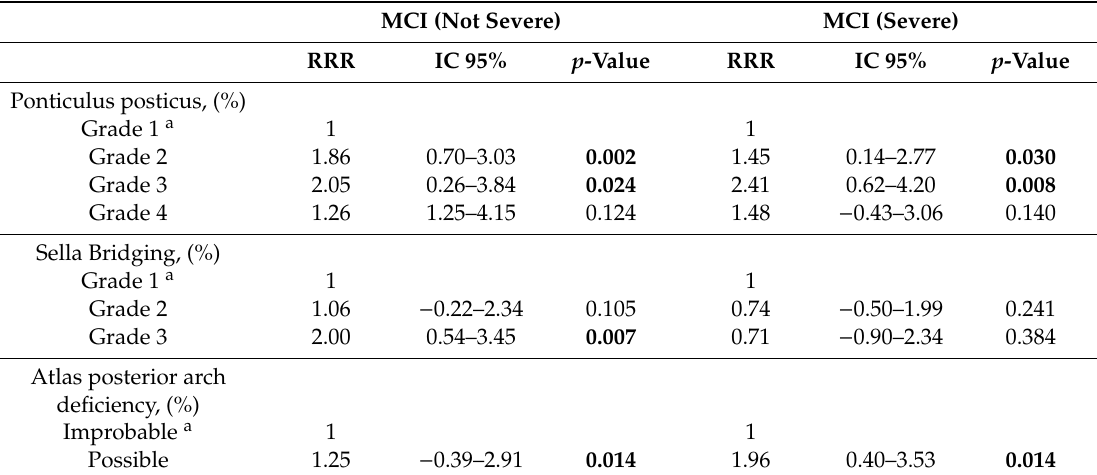
Table 7. Estimated relative risk ratios of having severe or not severe MCI by multinomial logistic